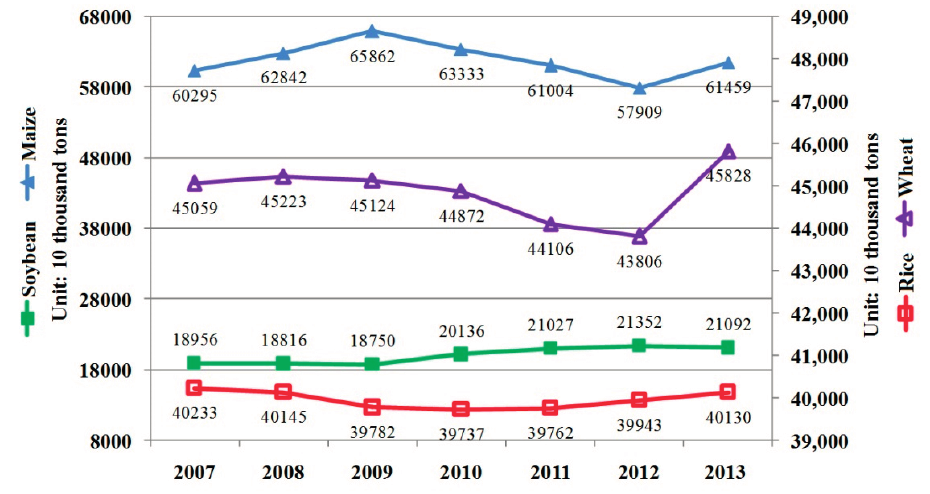
Figure 15. Three year moving average production of maize, rice, wheat and soybean of major producers.